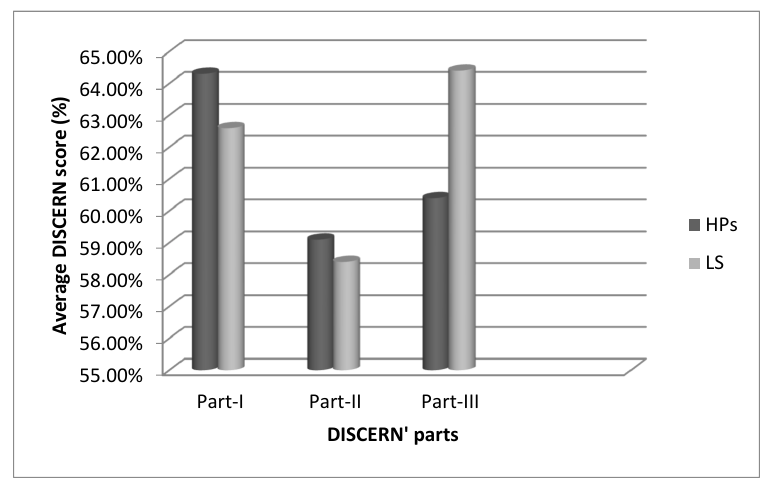
Figure 6. Results comparison by both groups (HPs and LS).